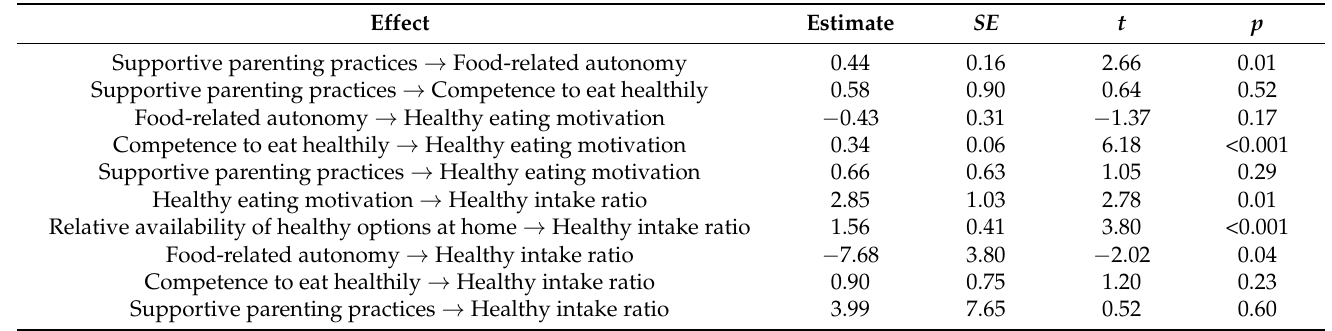
Figure 3. Path model with standardized coefficients (bold indicates statistically significant) and squared multiple correlations. Table 5. Unstandardized parameters of the path